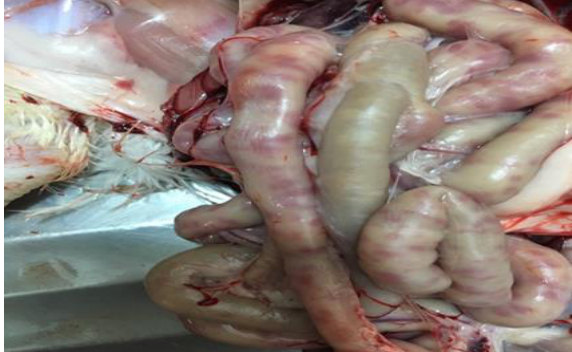
Figure, 2: Intestine from experimentally infected broilers showed clear hemorrhagic foci that appeared dark red from outside vision. Blood contents were appeared clearly in open intestine (the arrow).